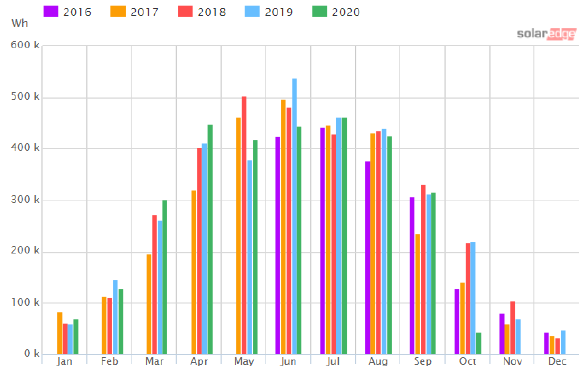
Figure 2: Electricity production by the photovoltaic carport